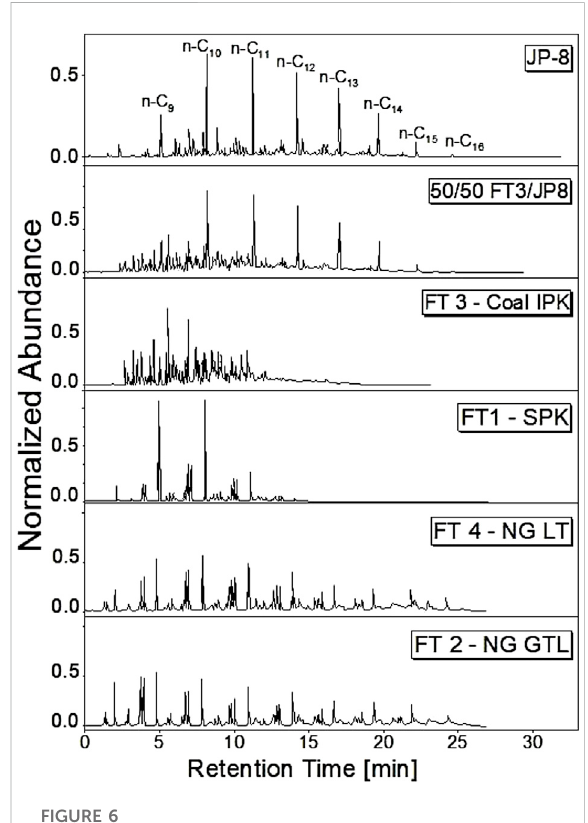
FIGURE 6 Neat JP-8, FT and 50/50 FT3/JP8 blend TICs (Blakey et al., 2022).